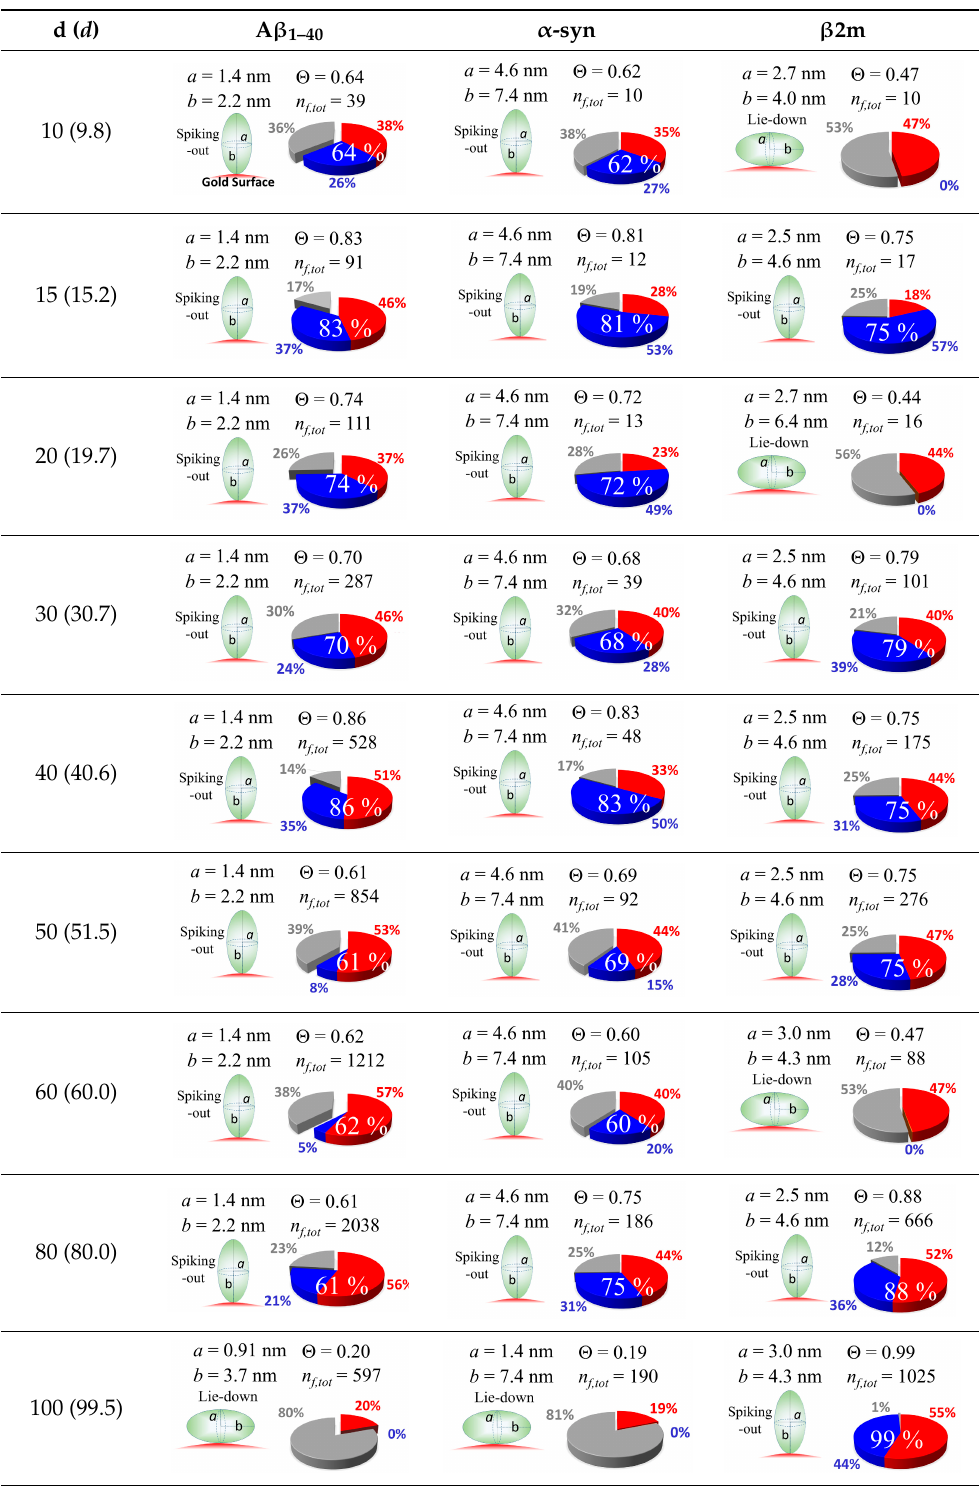
100 (99.5) 100 (99.5)